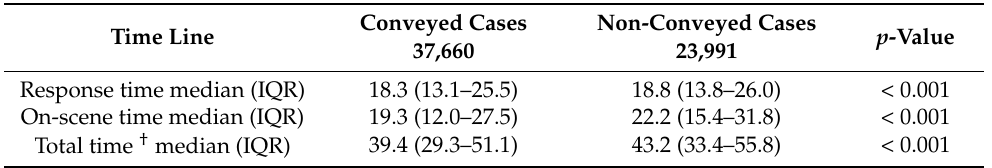
Table 2. Timeline differences between transported and non-conveyance emergencies due to patient- initiated refusal (n =